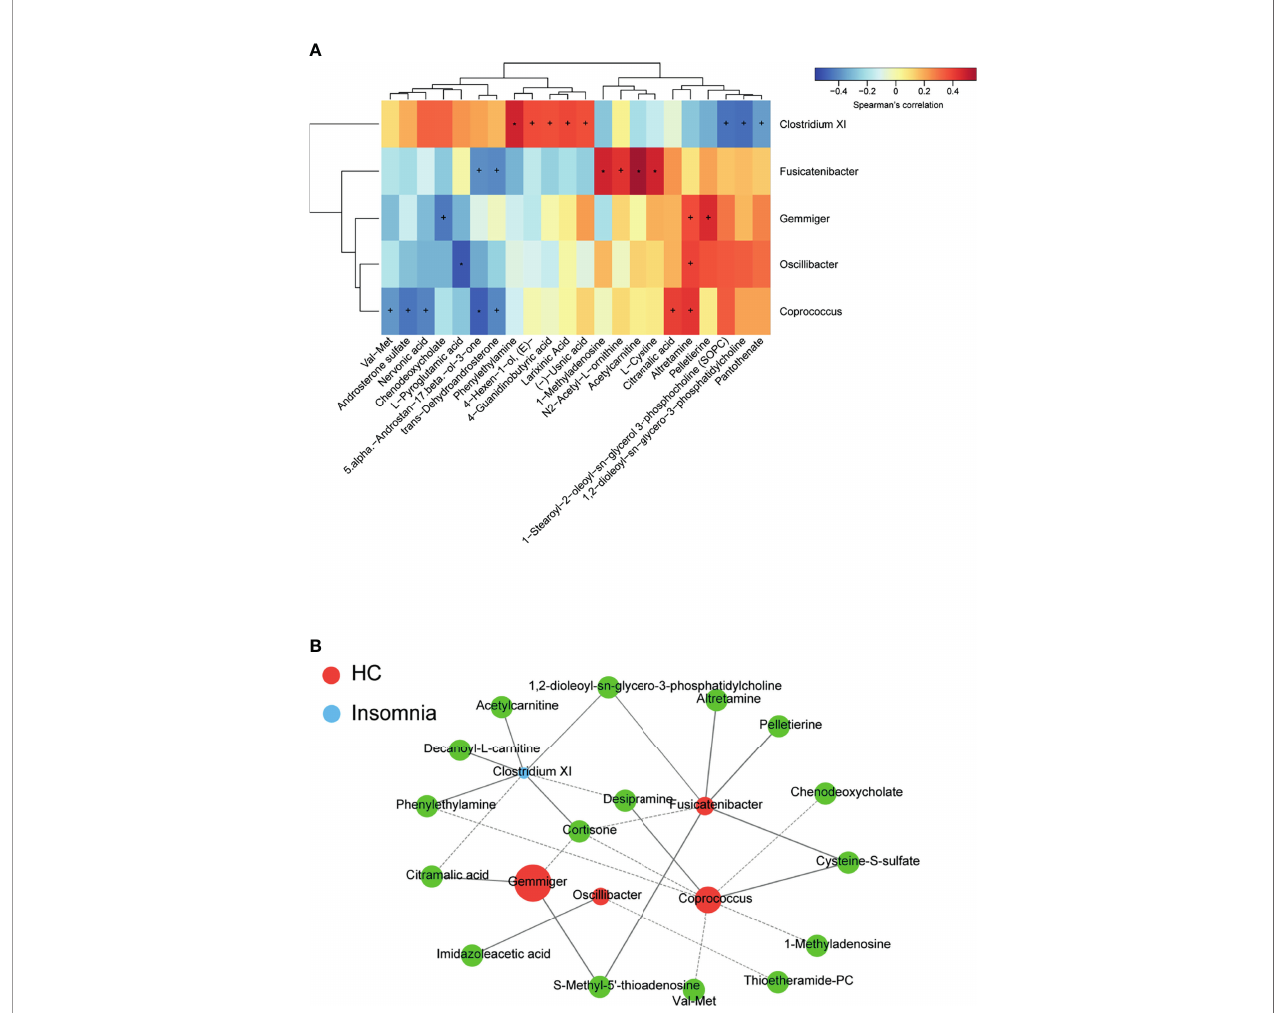
FIGURE 6 | Correlations between insomnia-related gut bacterial genus and serum metabolites. (A) A heat map of Spearman ’ s rank correlation coef fi cients and p-values of the correlation analysis. + p < 0.05; *p < 0.01. (B) A bacteria-metabolite network. Orange dots represent the dominant gut bacteria in insomnia disorder. Blue dots represent the dominant gut bacteria in healthy control. The size of each dot re fl ects the impact value of each gut bacterial genus. The green dots represent